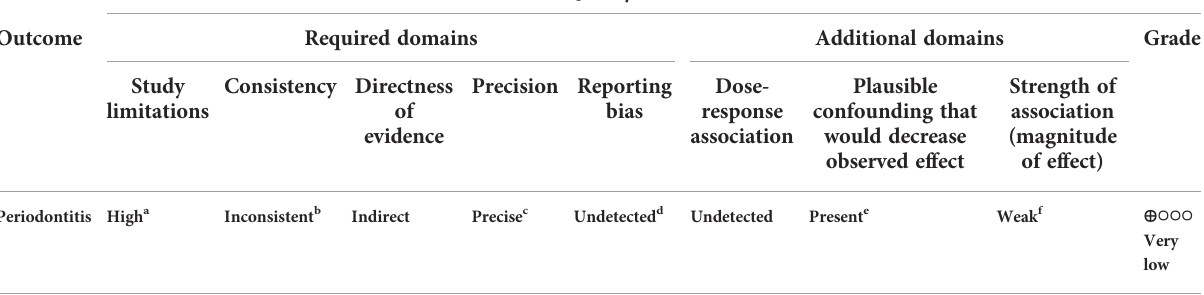
TABLE 3 GRADE approach for the primary